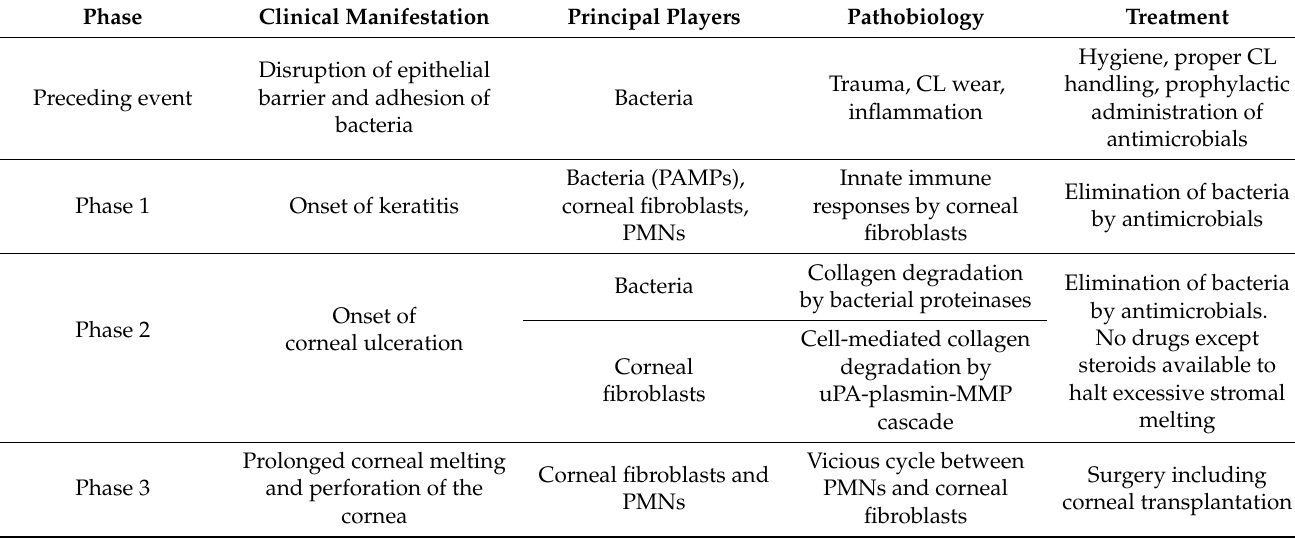
Table 1. Phases of bacterial infection of the